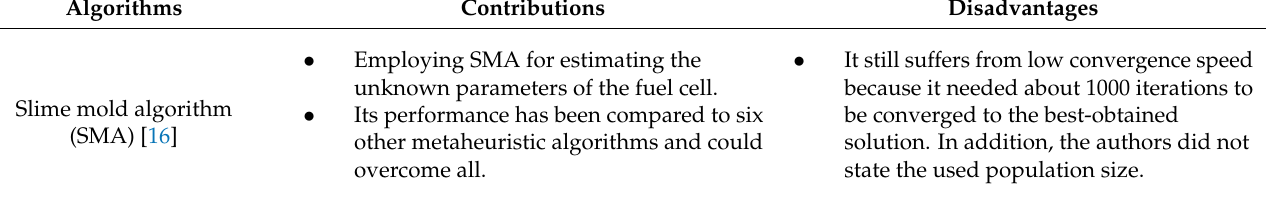
Table 1. Reviewing some published parameter estimation techniques for the